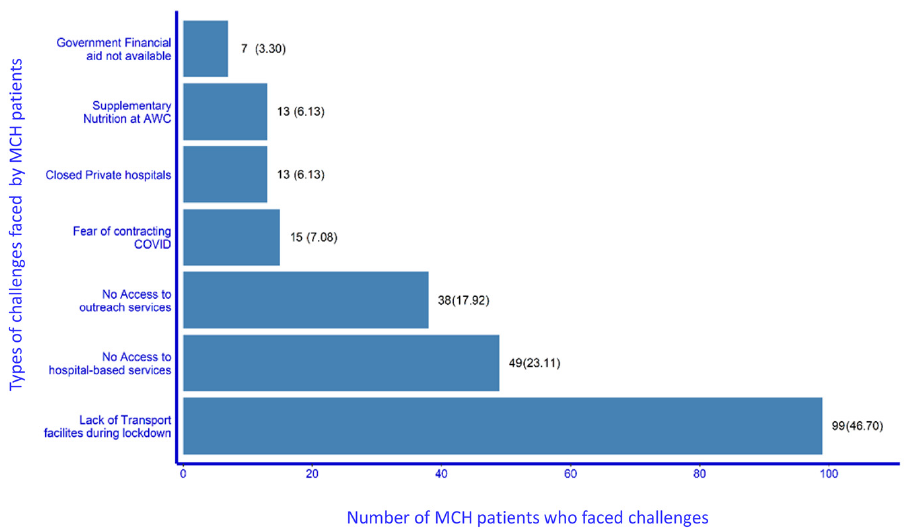
Figure 3. Types of challenges in accessing MCH services faced by patients during the COVID-19 lockdown (n = 212). Footnote: It is possible for one patient to report more than one challenge; hence,